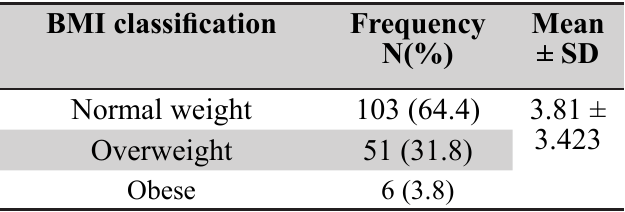
Table 2: Distributions of respondent’s BMI (N=160) BMI